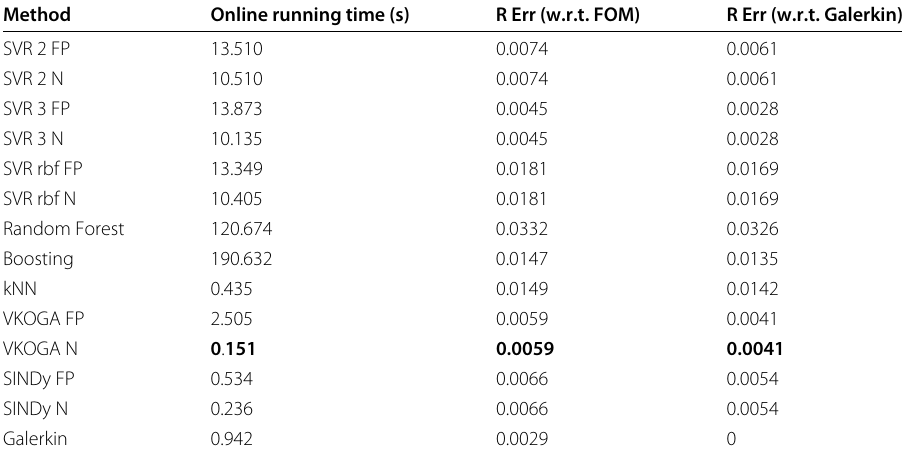
Table 3 Comparison of different machine learning methods using the Backward Euler integrator for 2D convection–diffusion equation: Newton’s method (N); FP-fixed-point iteration (FP)